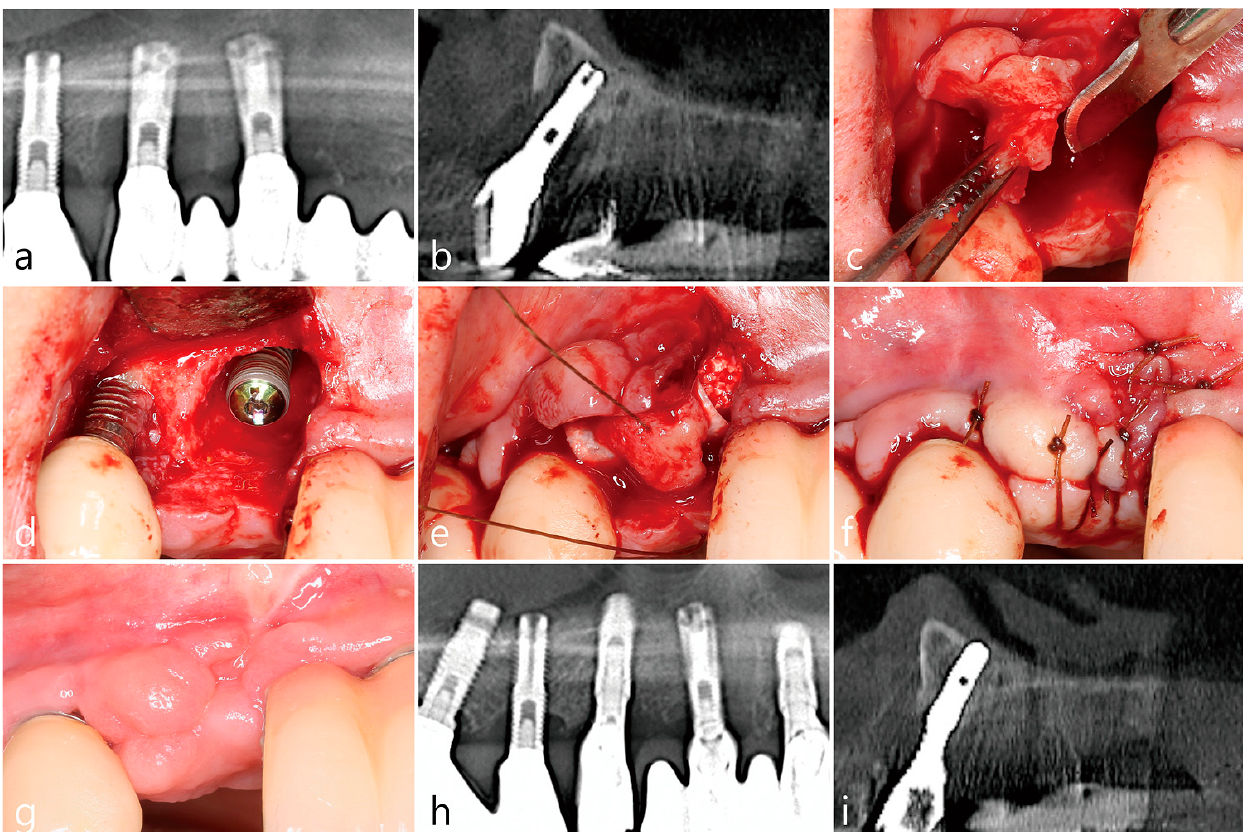
Figure 4. Clinical and radiological findings of case #4. ( a ) Pre-operative panoramic radiograph showing severe bone resorption and periapical radiolucency around the existing implant #13. ( b ) Cross-sectional image of CBCT #13 showing ICT. ( c ) Flap extension by dissection of the ICT attached to the buccal flap with the base attached to the existing flap using a #15 blade. ( d ) Implant #13 placement with peri-implant osseous defect. ( e ) Bone graft and resorbable collagen membrane placement over implant. Extended IGT sutured to palatal flap. ( f ) Flap closure with extended IGT. ( g ) Post-operative photograph showing healing with no flap exposure. ( h ) Panoramic radiograph taken 28 months after prosthesis delivery. ( i ) Cross-sectional image of CBCT taken 28 months after prosthesis delivery with sufficient bone regenerated around the implant.